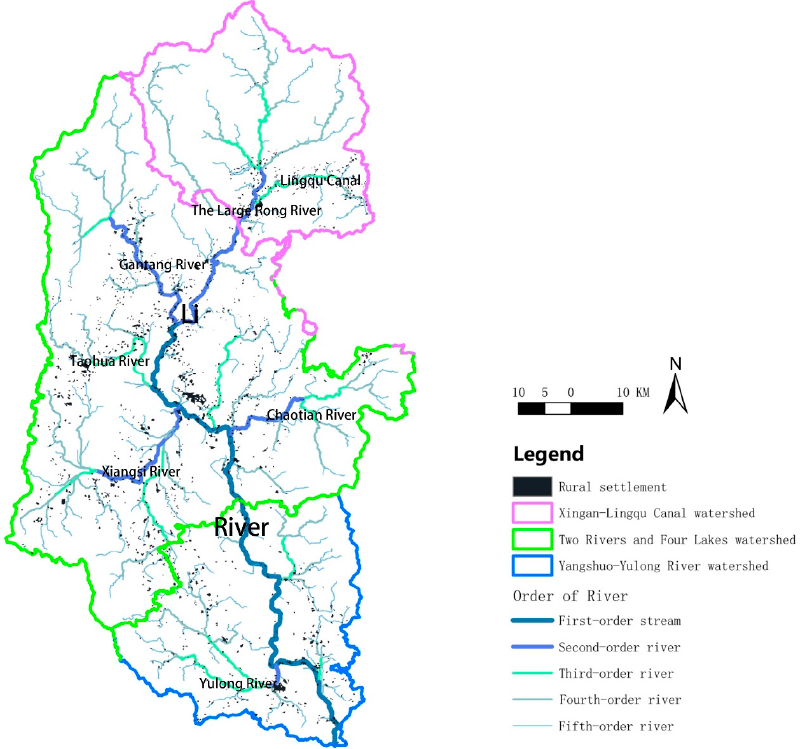
Figure 8. River grading map of rural settlement distribution in the Lijiang River Basin. Black spots indicate rural settlements.